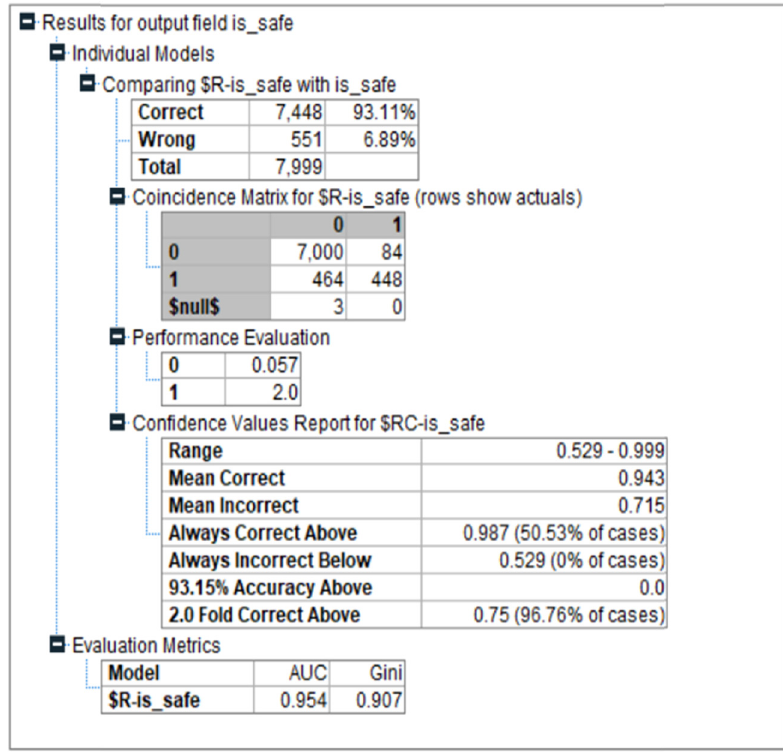
Figure 5: CHAID results.